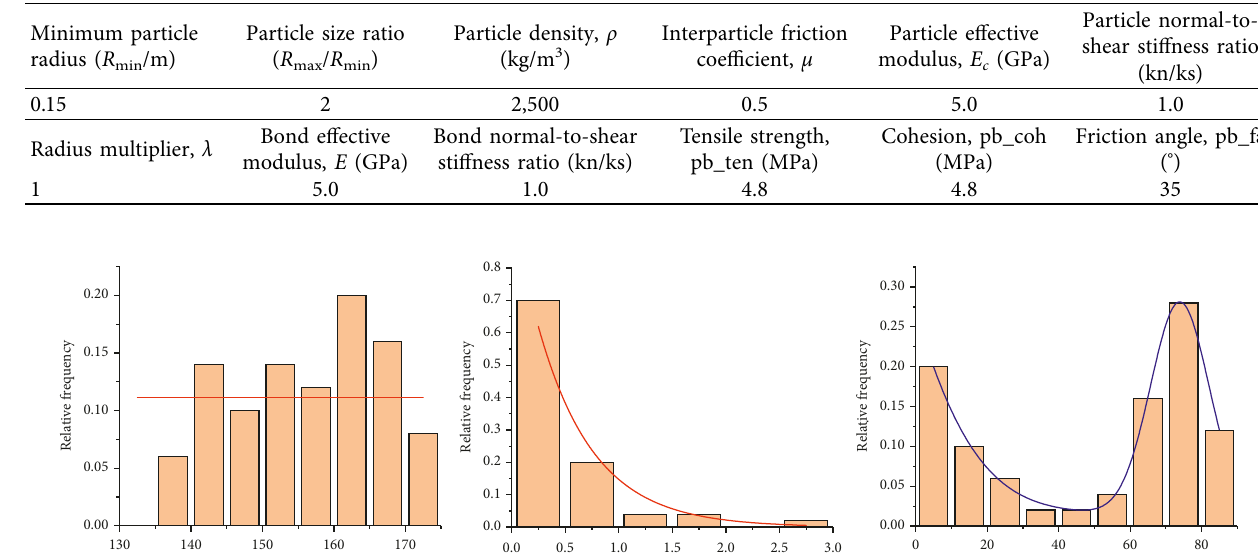
Table 1: Model parameters of particle model.